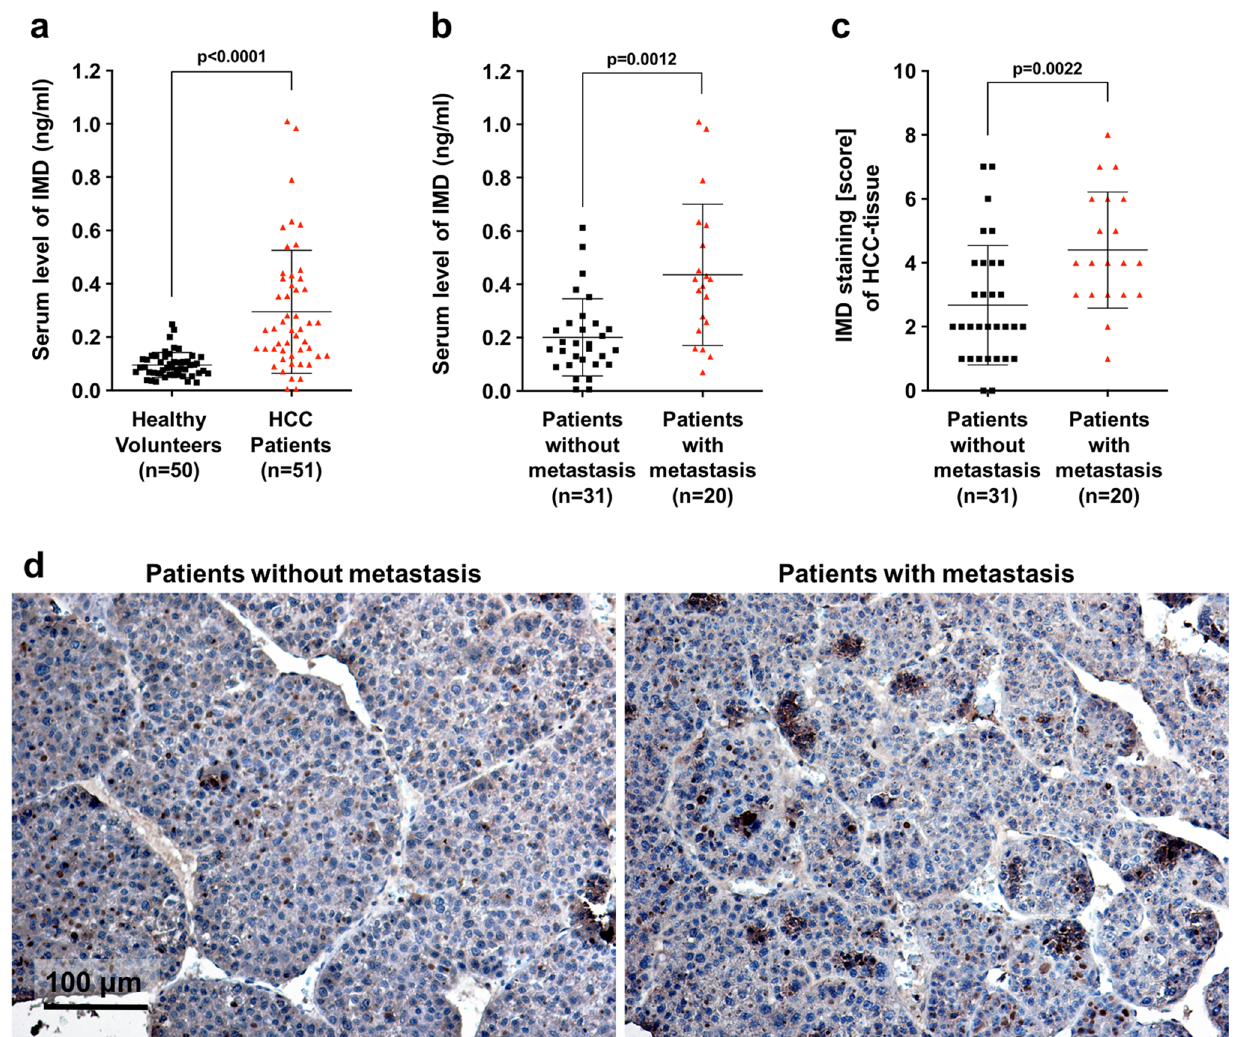
Figure 1. IMD expression was higher in HCC patients with metastasis. ( a ) The IMD levels in healthy volunteers and in patients with HCC were presented as scatter plots with mean ± SD. ( b ) The IMD mRNA levels in HCC patients with or without metastasis. ( c ) The IMD staining scores in HCC patients with or without metastasis. ( d ) Representative images of the IHC staining. Significance was assessed by unpaired t test with Welch’s correction